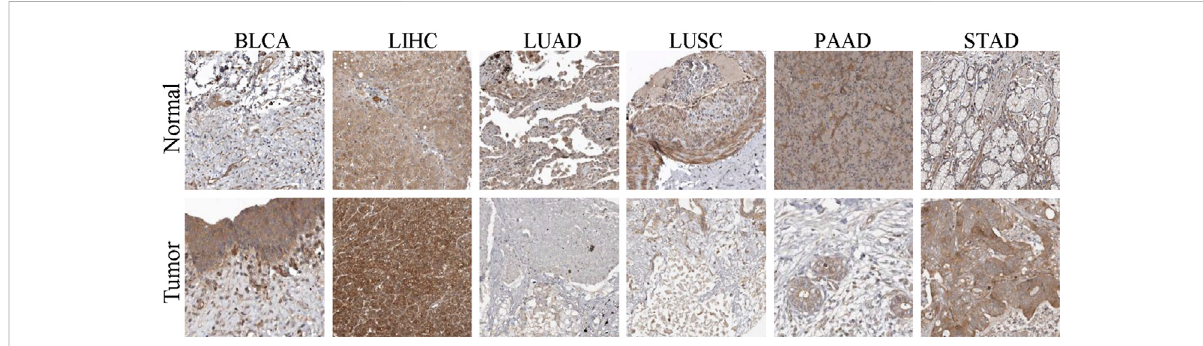
FIGURE 2 The IHC images of EXOC3L1 in normal and tumor tissues extracted from the HPA.